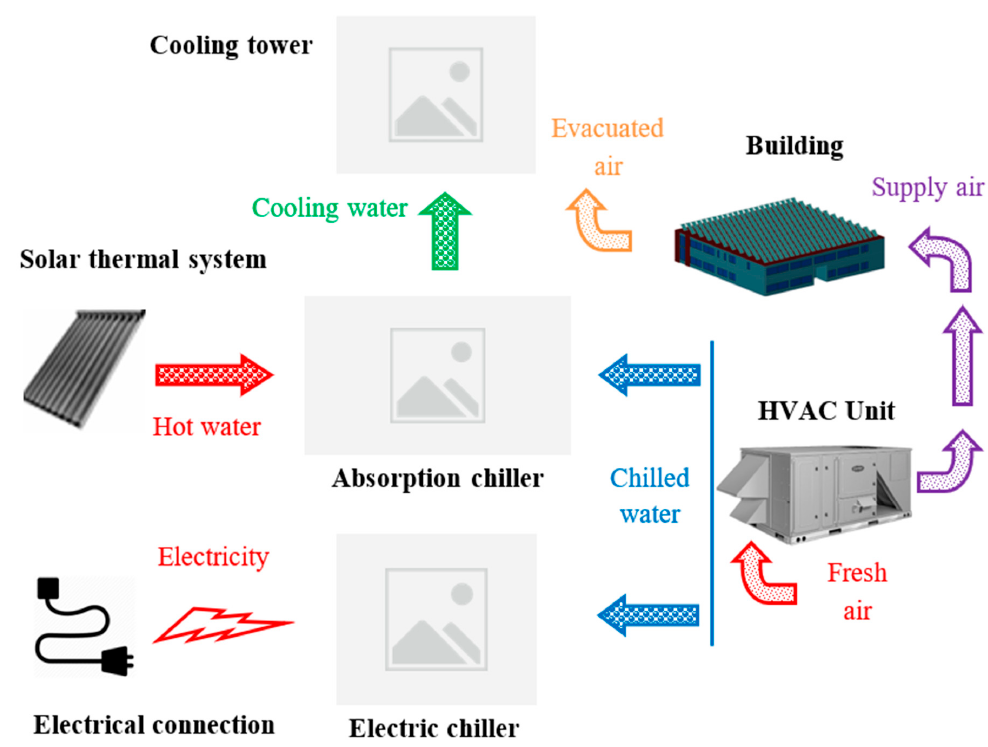
Figure 3. Energy flow scheme of a solar absorption fresh air cooling system.